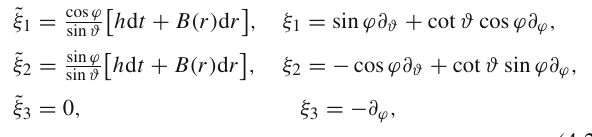
˜ ∂ μ ≡ = ( ˜ ξ , ξ ν ) , With 0, the so ( 3 ) Killing vectors, ξ N a μ a a ˜ ξ μ and ξ = ˜ ξ = ξ ν ∂ ν decompose explicitly into a a μ d x a a